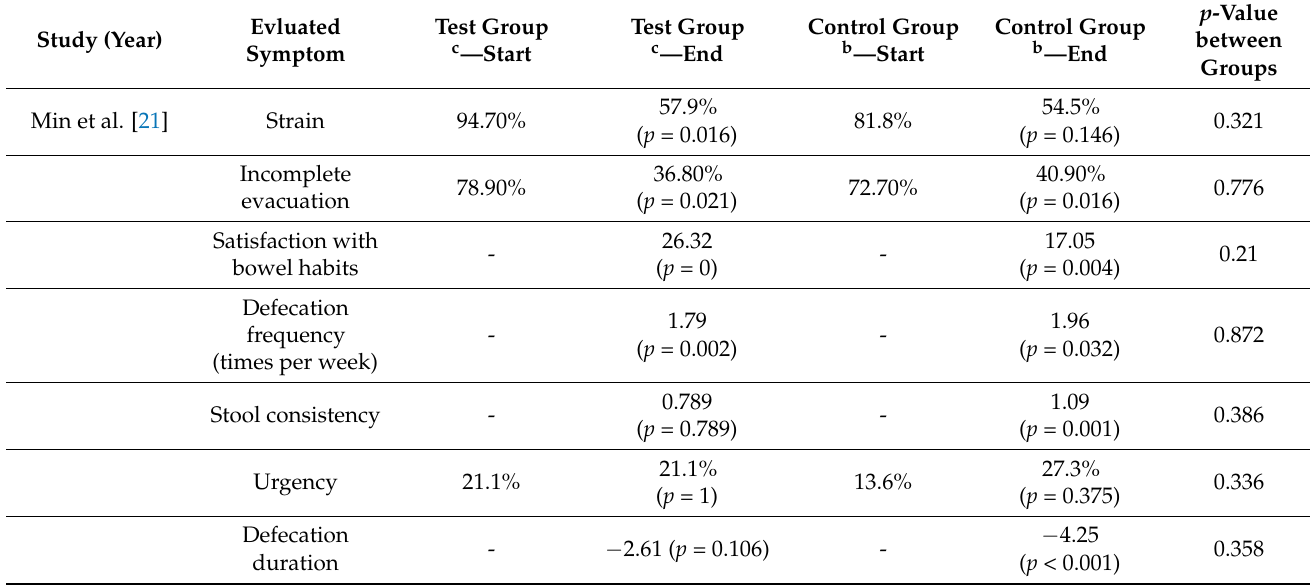
Table 4. Comparison of intestinal habits among patients suffering from